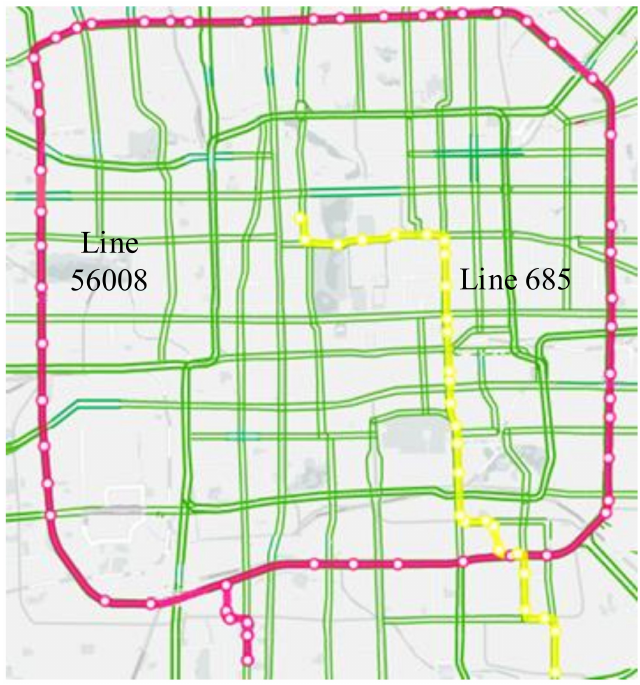
Figure 6. The two lines (line 56008 and line 685) used in this